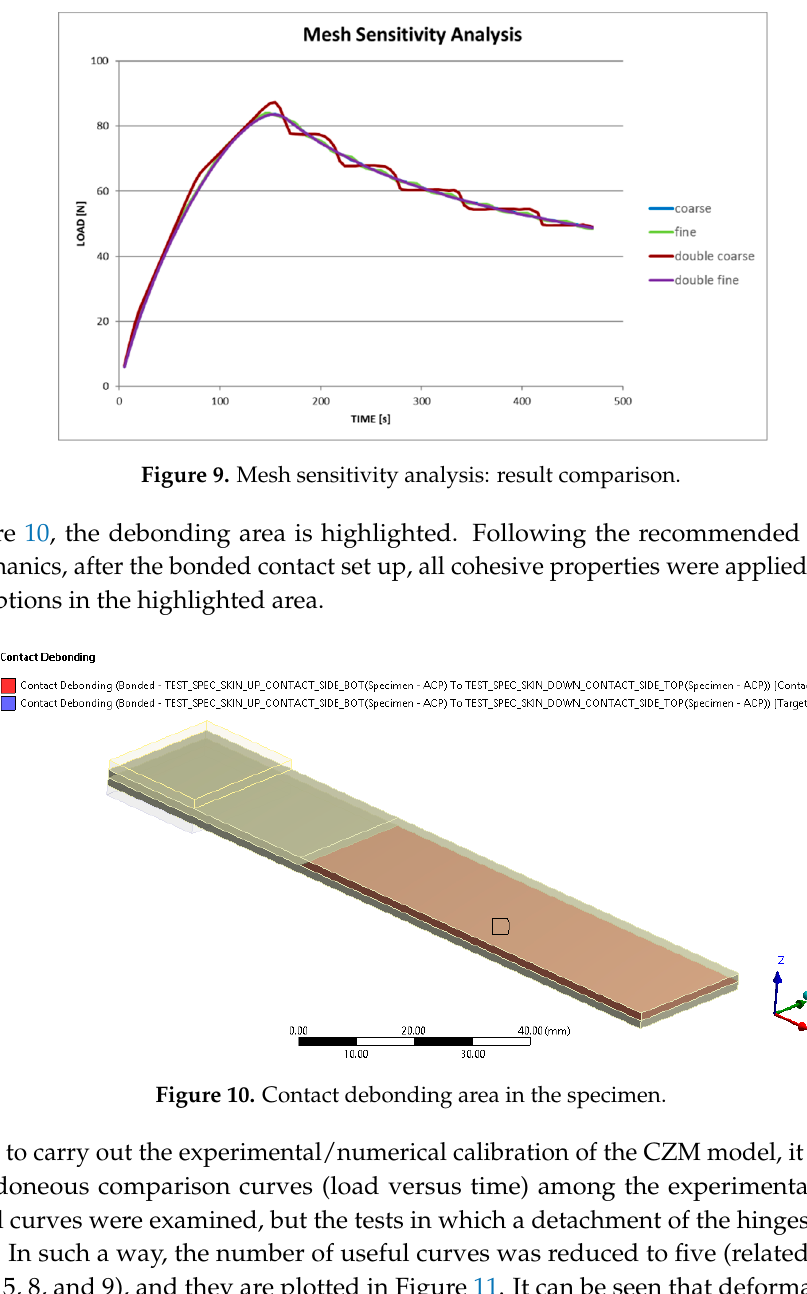
Figure 11. Experimental DCB curves for samples 3, 4, 5, 8, and 9. Table 1. Synoptic of the experimental G I energy values for delamination propagation . BT—beam theory; MBT—modified BT; CC—compliance calibration; MCC—modified CC. M1_1